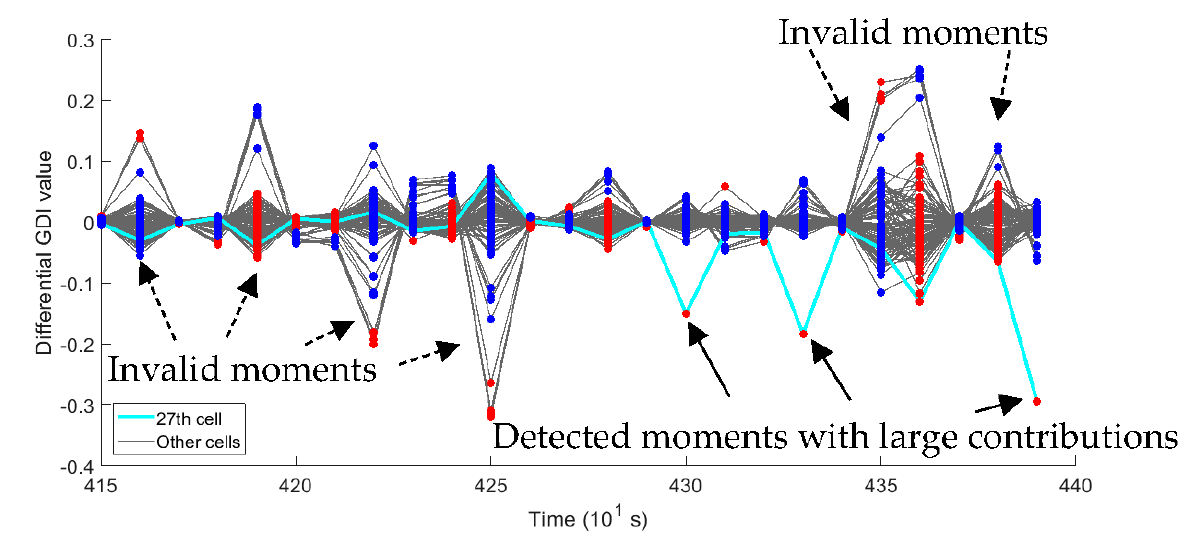
Figure 5. Zoom-in scatter plots of the sparsity-based clustering in the first case, with the points in different temporal clusters marked in red or blue.